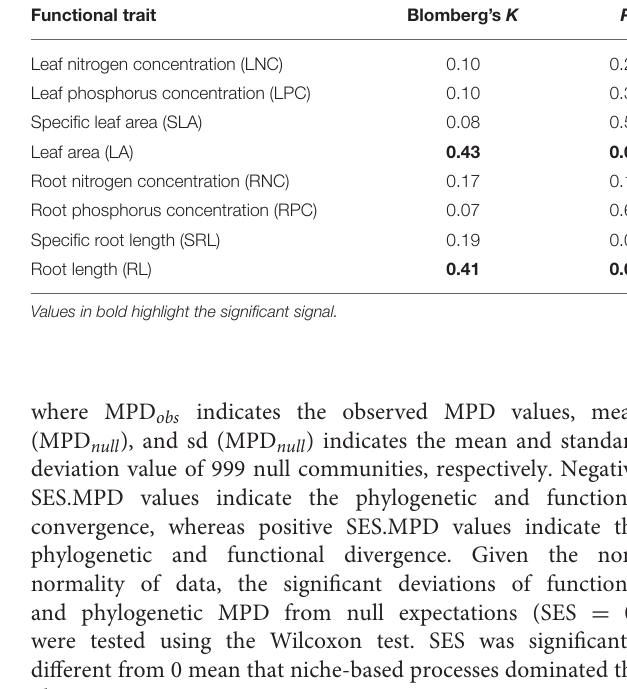
TABLE 1 | Phylogenetic signal of plant functional traits. Functional